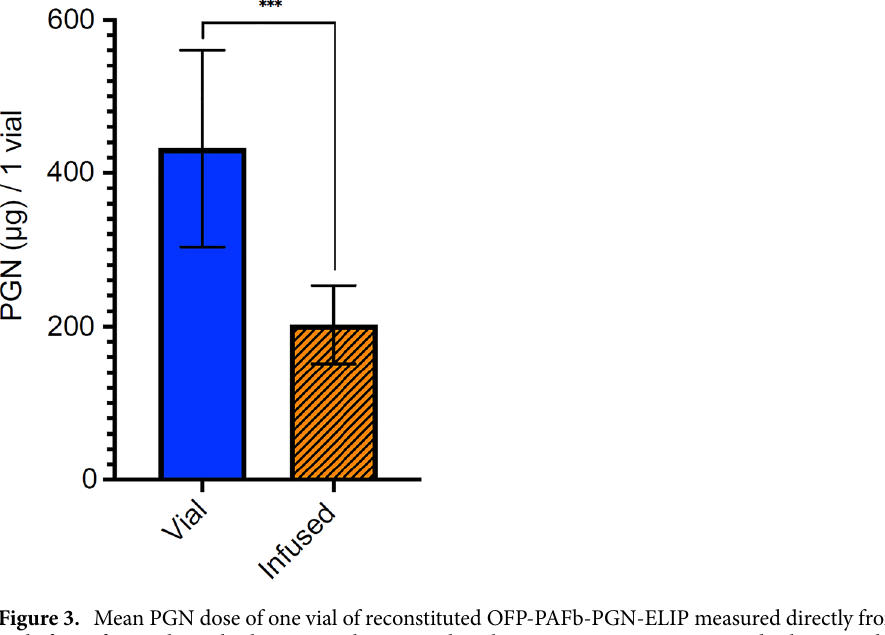
Figure 3. Mean PGN dose of one vial of reconstituted OFP-PAFb-PGN-ELIP measured directly from the vial and after infusion through EkoSonic catheters. Each vial contains 0.5 mL reconstituted solution and 10 mg lipid/ mL solution. Error bars represent ± s.d., n = 3 vials